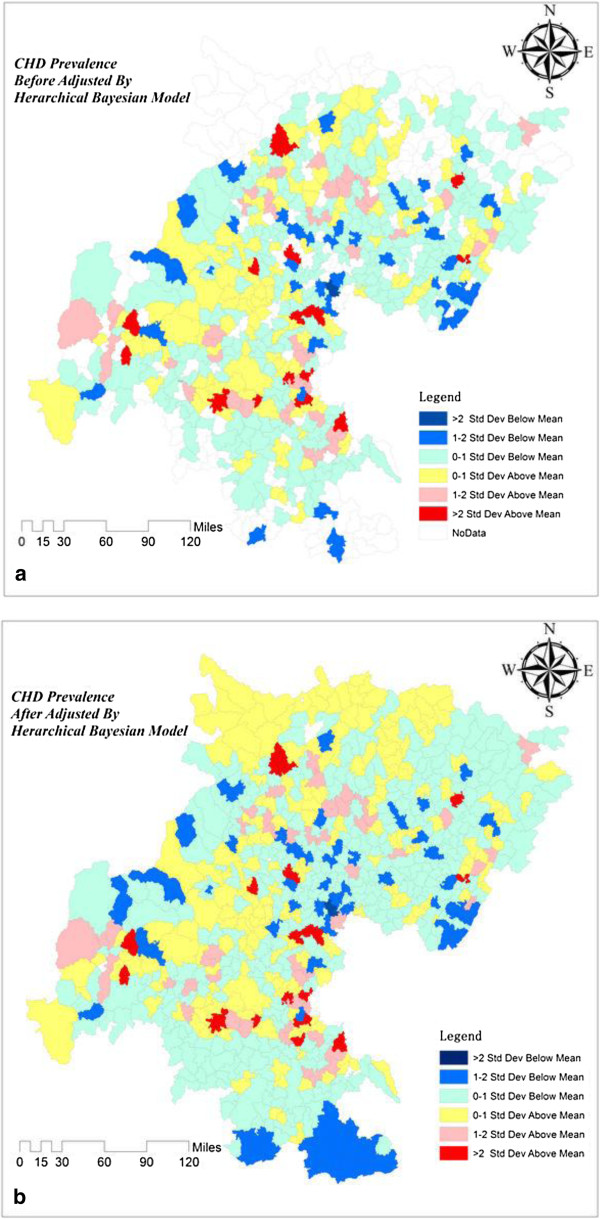
CHD Prevalence Map Before and After Adjustment by HB. (a) is the map of CHD prevalence before adjusted by HB model, (b) is the map of CHD prevalence after adjusted by HB model.